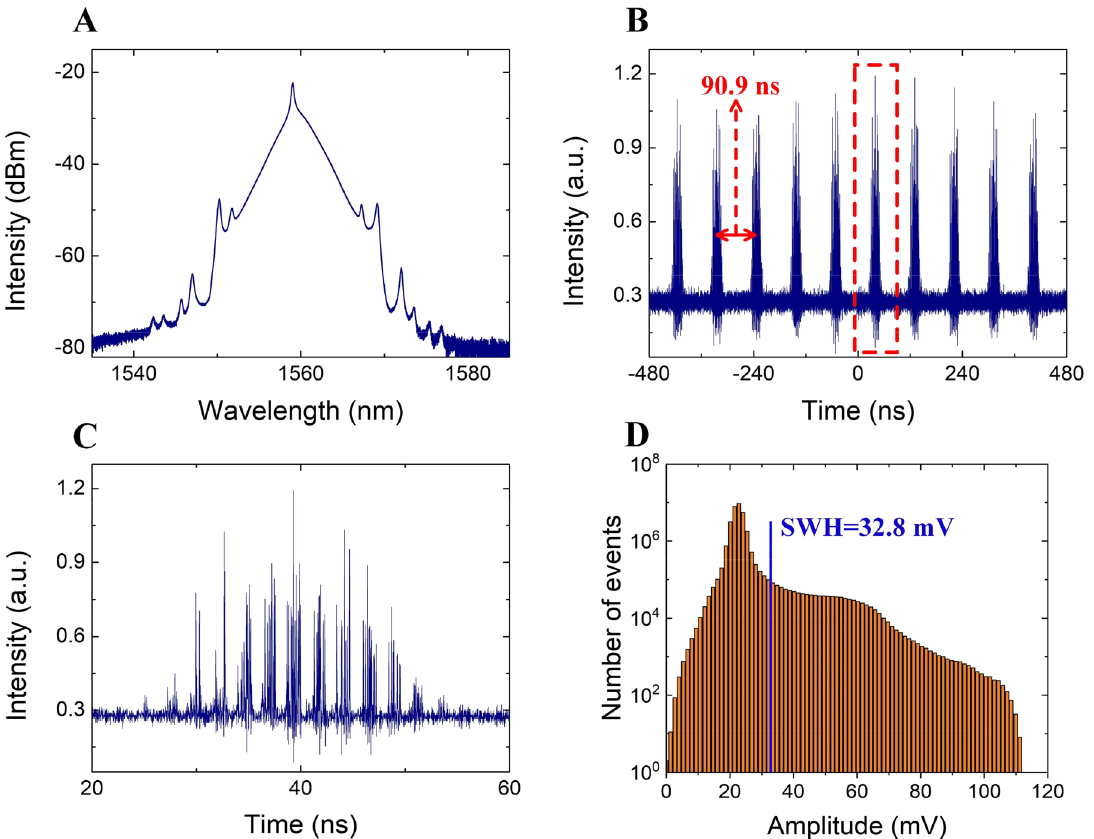
Figure5: Multiple-pulseoperationat1550nm.(A)Opticalspectrum,(B)pulsetrains,(C)magni fi edtrainsinreddashedpartof(B),(D)intensity